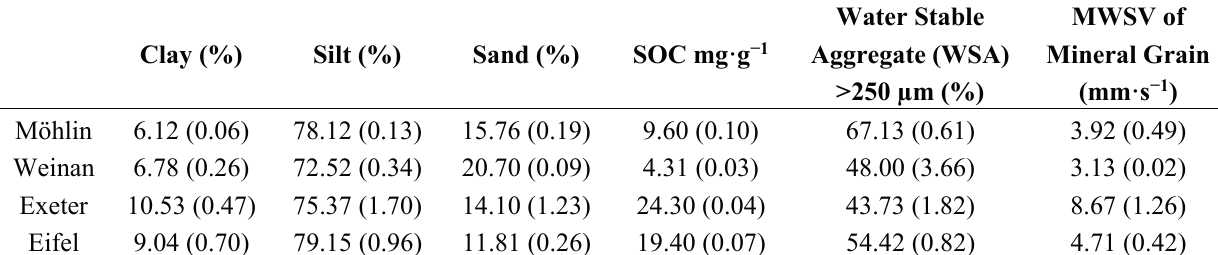
Table 3. Selected soil properties of the four soils. Numbers in brackets represent standard deviations. MWSV: Mean Weight Settling